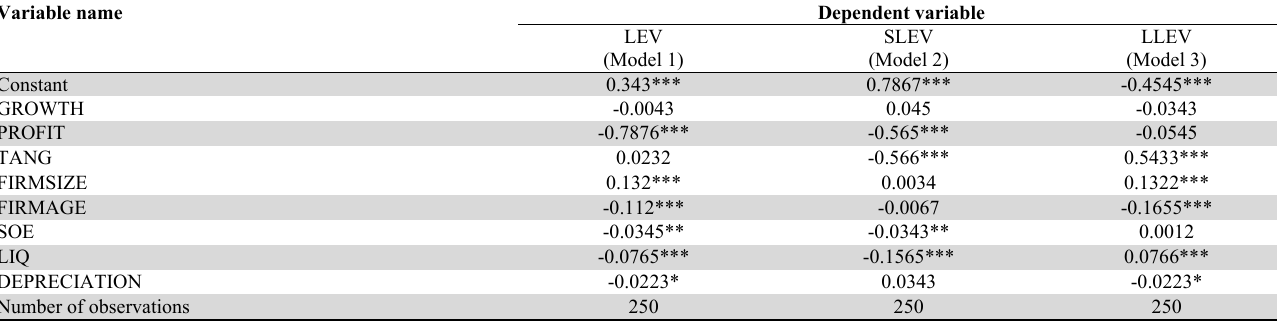
Results using GLS